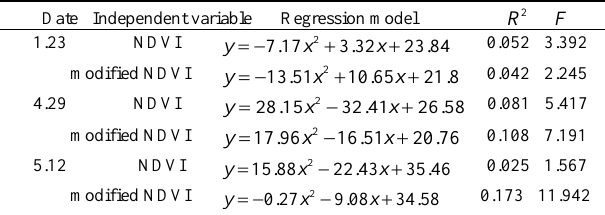
Table 8. 10cm soil moisture regression model in southern